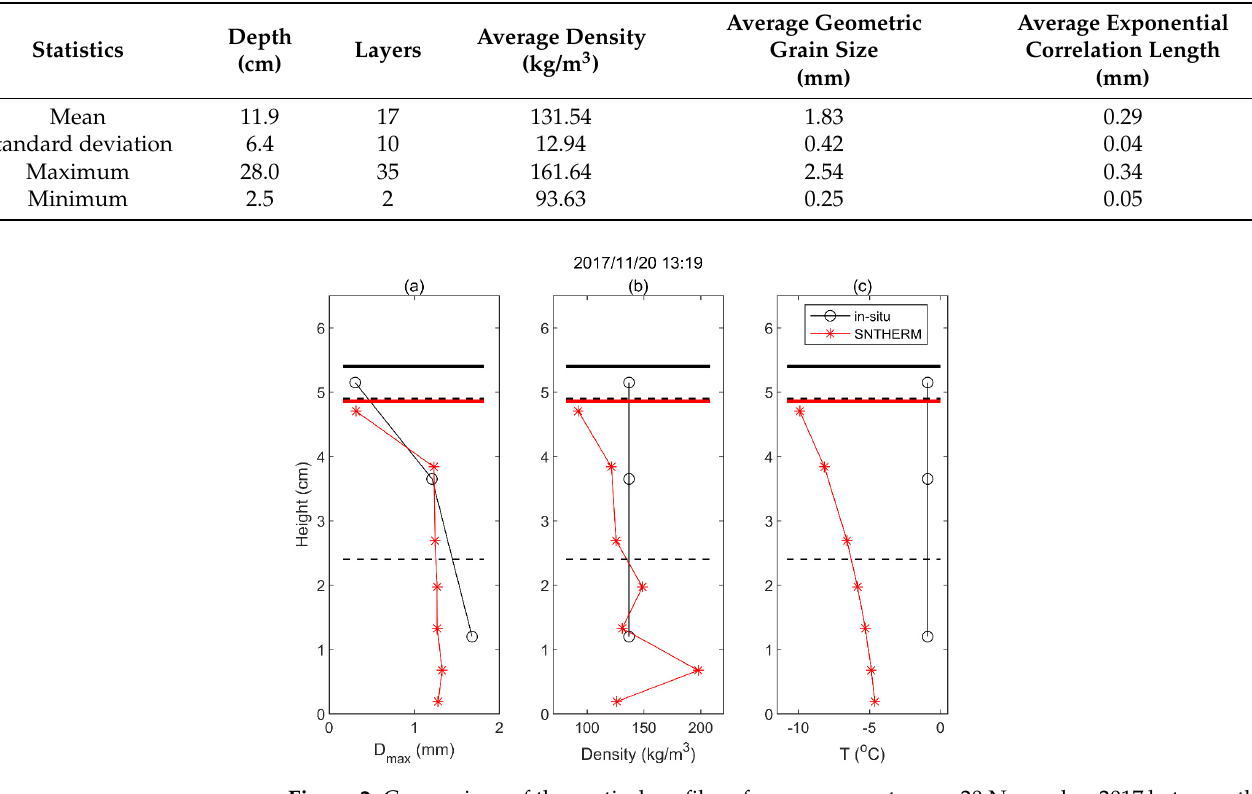
Figure 2. Comparison of the vertical profiles of snow parameters on 20 November 2017 between the SNTHERM simulations and Altay in situ measurements: ( a ) geometric grain size ( D max ); ( b ) snow density; and ( c ) physical temperature (T). The horizontal dashed lines in black are layer interfaces recognized from the in situ snowpits. The horizontal lines in black and red are the snow's surface of in situ measurements and SNTHERM simulations, respectively.